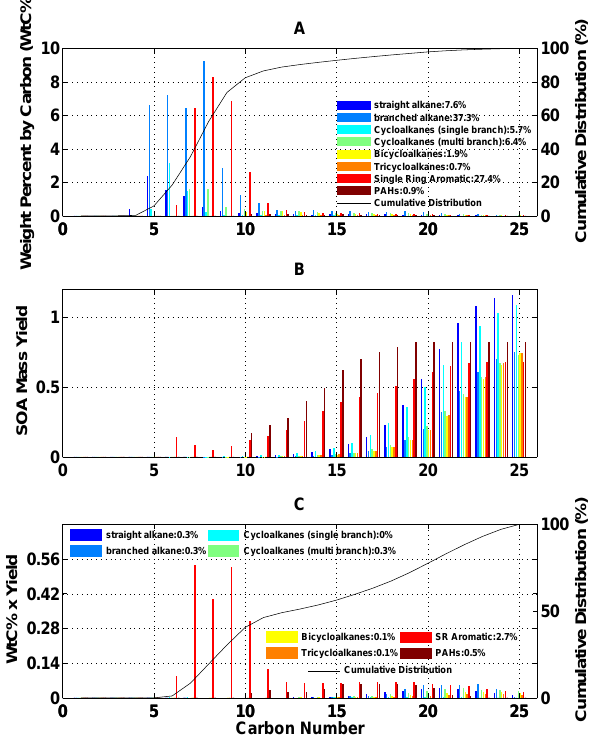
Fig. 2. Distribution of mass by chemical class based on California fuel-sale data comprising 13% diesel and 87% gasoline, by volume (top panel). Distribution of compound specific SOA mass yields (middle panel). Relative contributions of each group of species to predicted SOA, calculated as the yields multiplied by weight per- cent (by carbon) in liquid fuel (bottom panel). Data are from Ta- bles S5, S6, and S8 of Gentner et al.